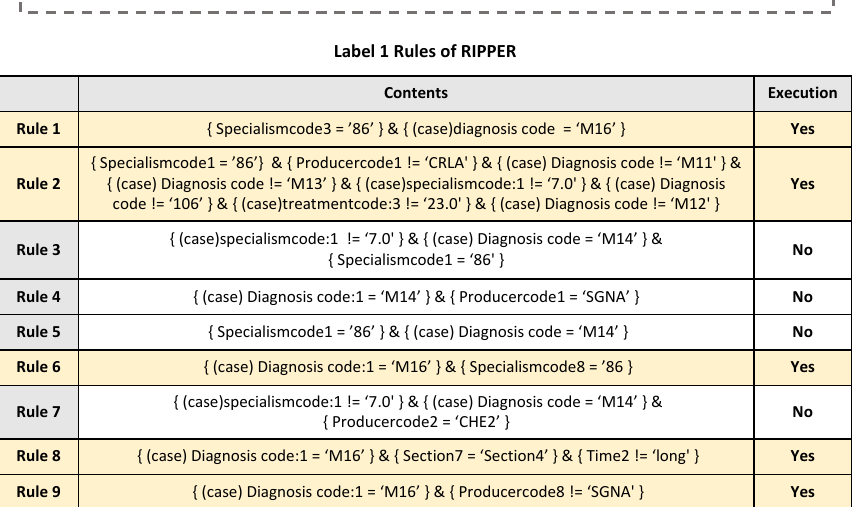
Figure 5. Example of local-level model visualisation (a trace of the BPIC 2011 event log at prefix